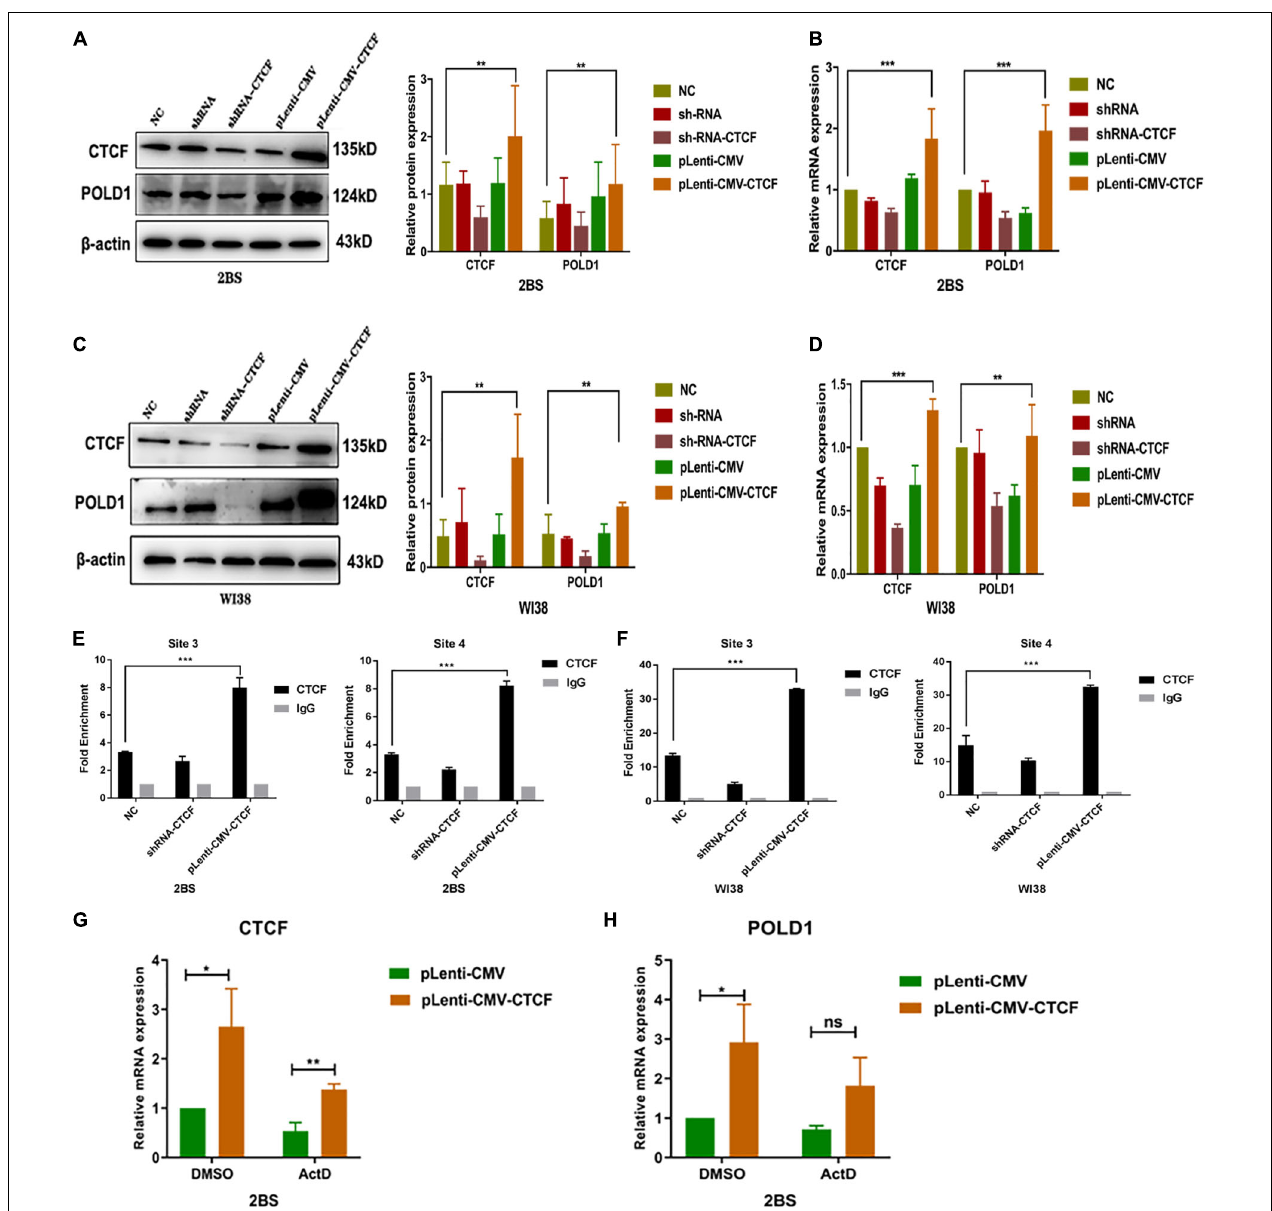
FIGURE 4 | CCCTC-binding factor (CTCF) upregulated DNA polymerase delta 1, catalytic subunit (POLD1) expression by elevating the binding level of CTCF to the POLD1 promoter. (A,C) Protein expression levels of CTCF and POLD1 in 2BS (A) and WI38 cells (C) . (B,D) mRNA expression levels of CTCF and POLD1 in 2BS (B) and WI38 cells (D) . (E,F) Site 3 and 4 binding levels of CTCF at the POLD1 promoter in 2BS (E) and WI38 cells (F) transfected with short hairpin RNA (shRNA) and CTCF overexpression lentivirus. (G,H) CTCF (G) and POLD1 (H) mRNA levels in 2BS cells transfected with pLenti-CMV-CTCF lentivirus. Data were compared by one-way ANOVA and Student’s t -test, and data are shown as the mean ± SEM, with three independent experiments in each group. * P < 0.05, ** P < 0.01, *** P <